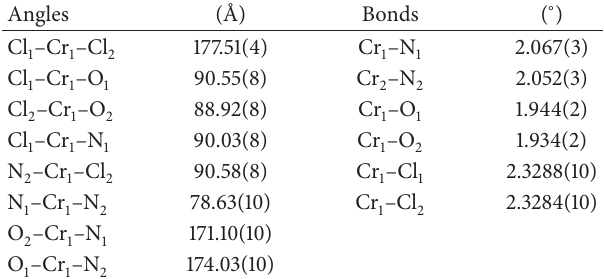
Table 3: Bond lengths (˚A) and angles ( ∘ ) of [Cr(Nor)(Bipy)Cl OH around Cr(III). Cl ⋅ 2CH 3